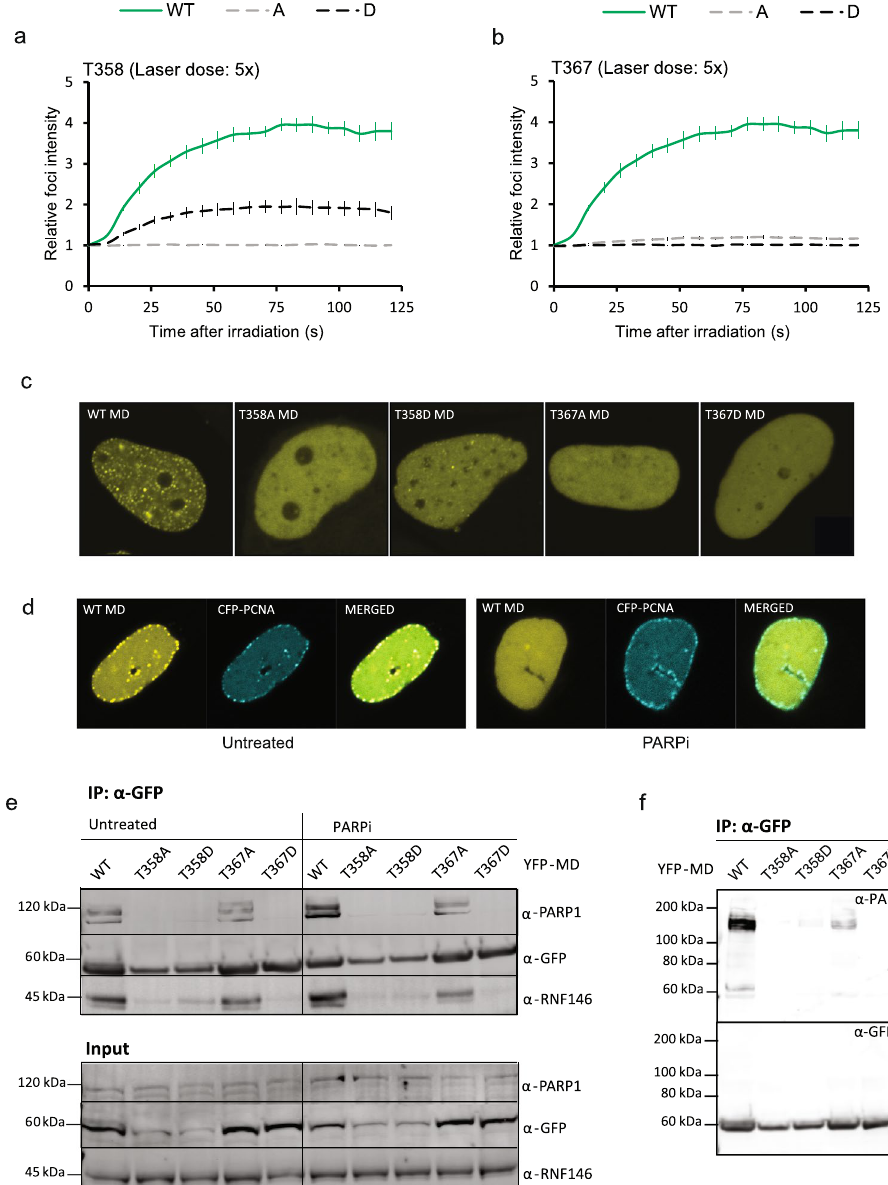
Figure 5. PAR-binding and recruitment to DNA damage of phosho-mimetic and phospho-defective T358 and T367 MD mutants. Average fold increase in mIF intensities of YFP-MD phospho-mimetic and phospho- defective mutants ( a ) T358 and ( b ) T367 using a 5x laser dose. Wild type YFP-MD (WT, green line): n = 10, T358A (grey dotted line): n = 8, T358D (black dotted line): n = 10, T367A (grey dotted line): n = 10, T367D (black dotted line): n = 8. Mean ± SEM. ( c ) Intracellular localization of wild type (WT), T358A/D, T367A/D YFP-MD in HeLa cells. ( d ) Intracellular localization of wild type YFP-MD and CFP-PCNA in CHO EM9 with and without PARPi (PJ34, 10 μ M, 1 hour). ( e ) Co-immunoprecipitation of PARP1 and RNF146 with wild type, T358A/D and T367A/D YFP-MD with and without PARPi (PJ34, 10 μ M, 1 hour) using 100 mM wash buffer. Cropped images of one out of five experiments with similar trends are depicted. ( f ) Co-immunoprecipitation of PARylated proteins with wild type, T358A/D and T367A/D YFP-MD using 1 M wash buffer. One out of three experiments with similar trend is